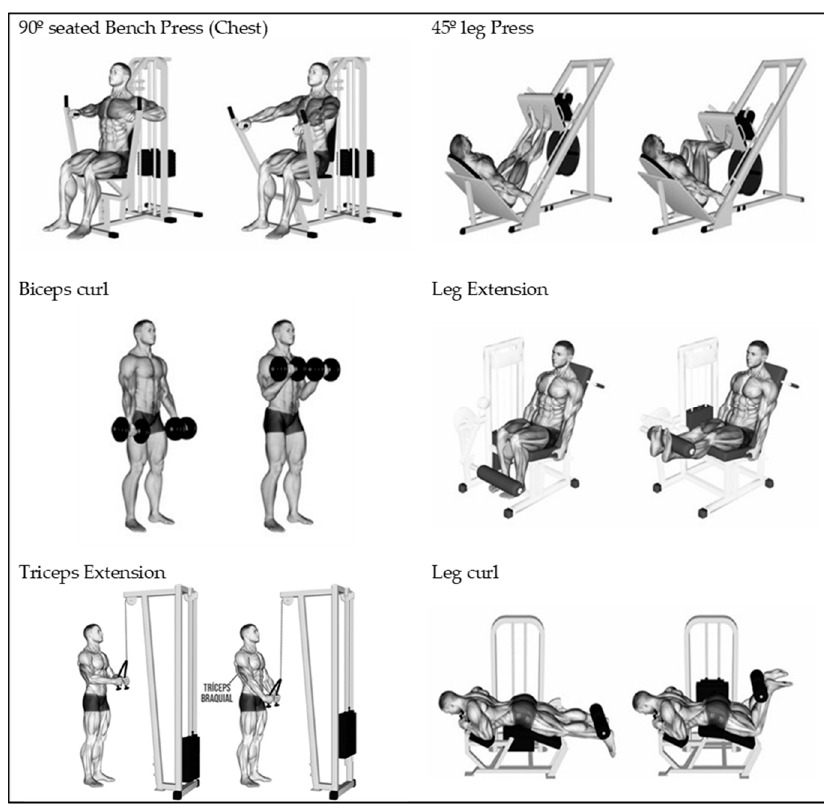
Figure 2. Training and testing exercises.